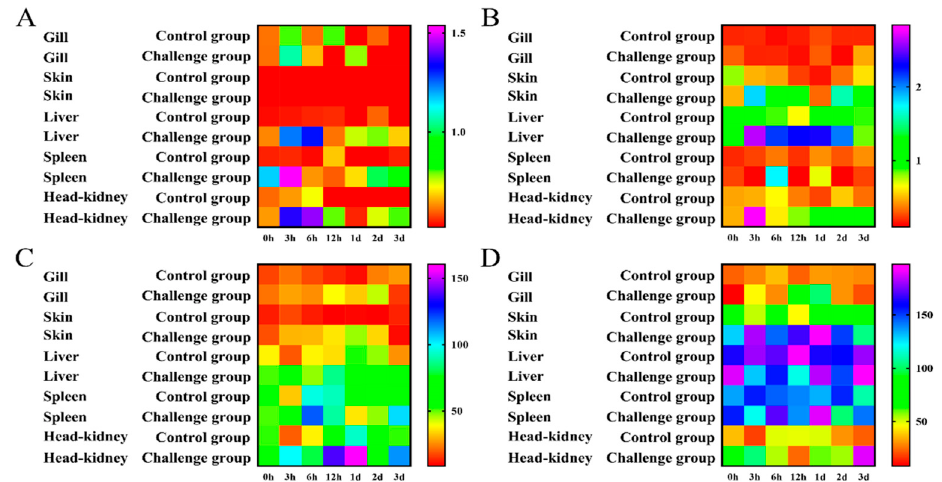
Figure 3. Enzyme activities of ACP ( A ), AKP ( B ), SOD ( C ) and LZM ( D ) were detected in gill, skin, liver, spleen and head kidney after infection with C. irritans (0 h, 3 h, 6 h, 12 h, 1 d, 2 d and 3 d). The heatmap was constructed using Graphpad Prism 5.0 software.